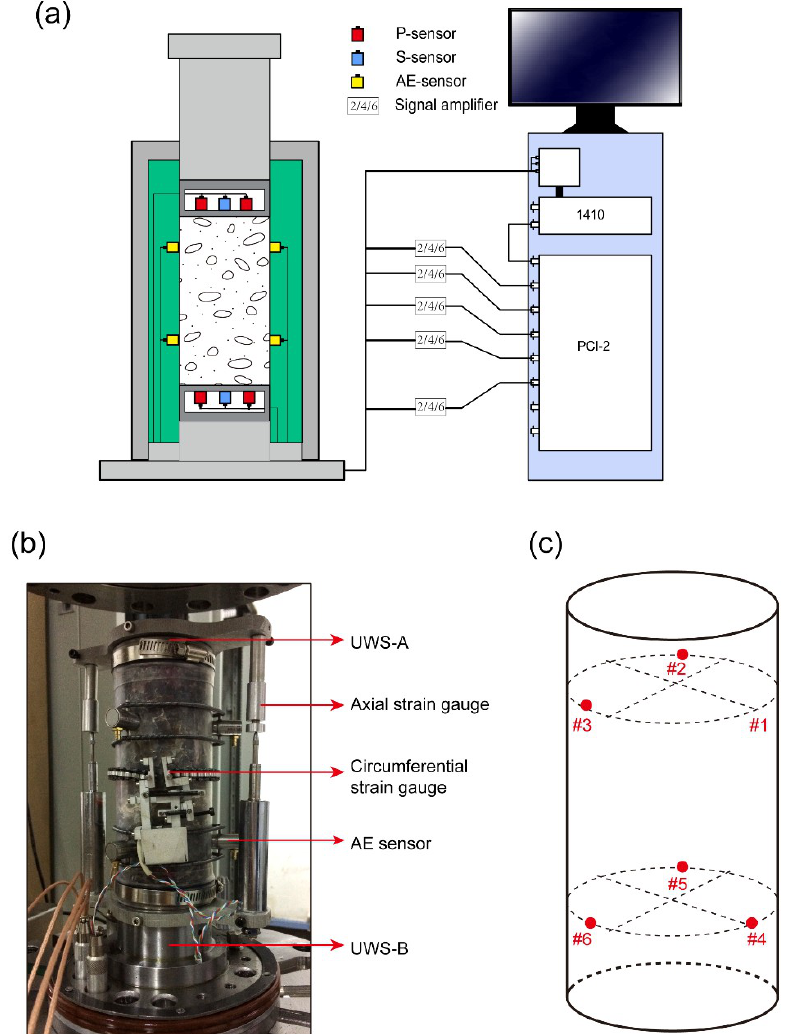
Figure 1. Triaxial compression loading test of rock salt specimens: ( a ) diagram of an integrated testing device with ultrasonic wave and acoustic emission (AE) activity; ( b ) installation of strain gauges, ultrasonic sensors, and AE sensors; and, ( c ) layout of six AE sensors.